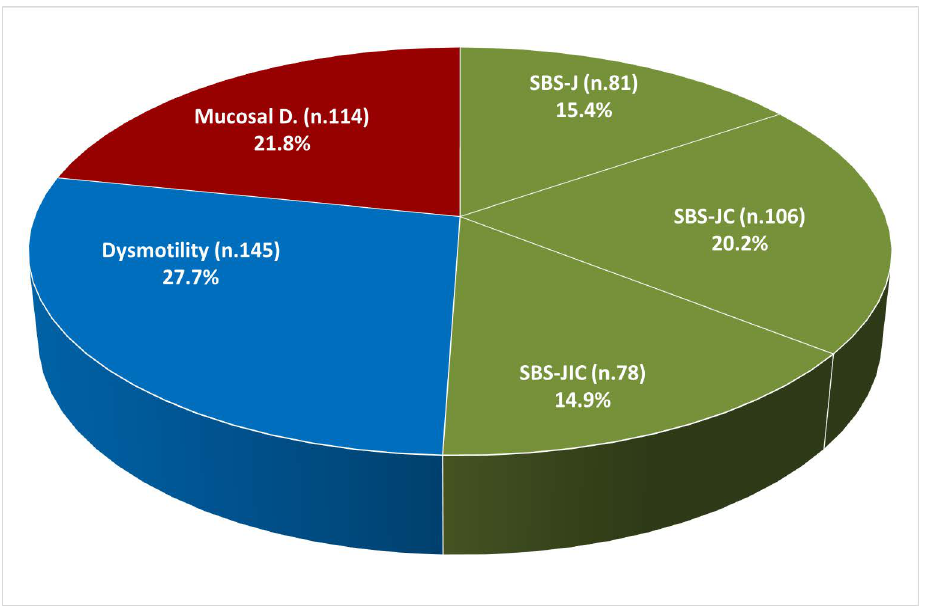
Figure 1. Pathophysiological mechanisms of chronic intestinal failure (n. 524). Abbreviations: SBS, short bowel syndrome; SBS-J, SBS with end jejunostomy or ileostomy (also included enterocutaneous fistulas, n. 7); SBS-JC, jejuno-colic anastomosis; SBS-JIC, jejunoileal anastomosis with an intact colon and ileocecal valve; Dysm, dysmotility (also included patients with mechanical obstruction, n. 8); Mucosal D, mucosal